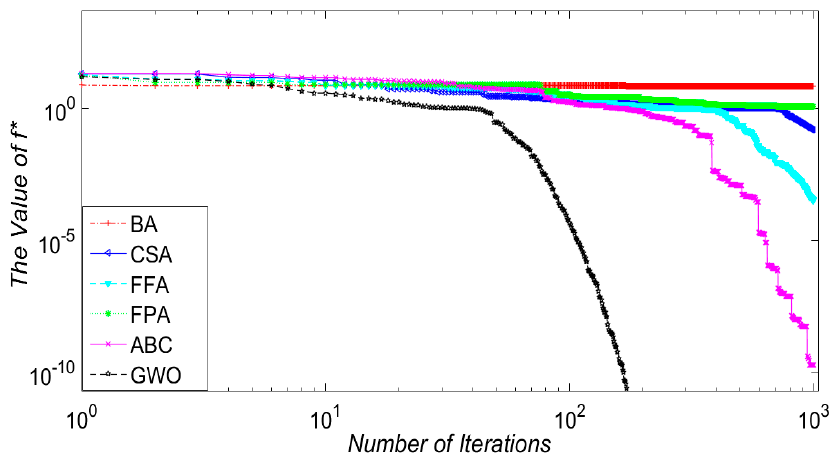
Figure 2. Convergence speed for Sphere ( f 1 ) function (50D).